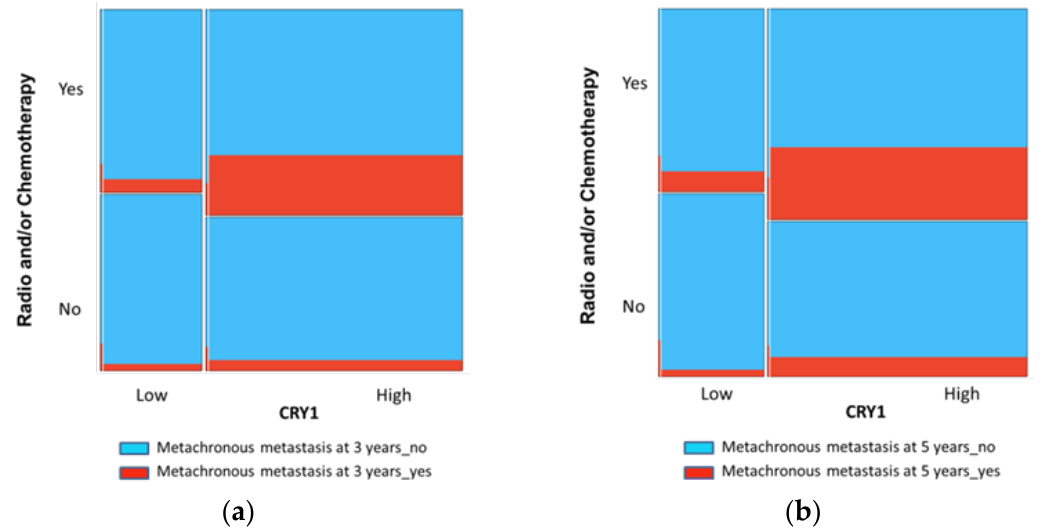
Figure 2. Mosaic plots showing the number of patients who have developed MM at 3 ( a ) and 5 ( b ) years after the diagnosis